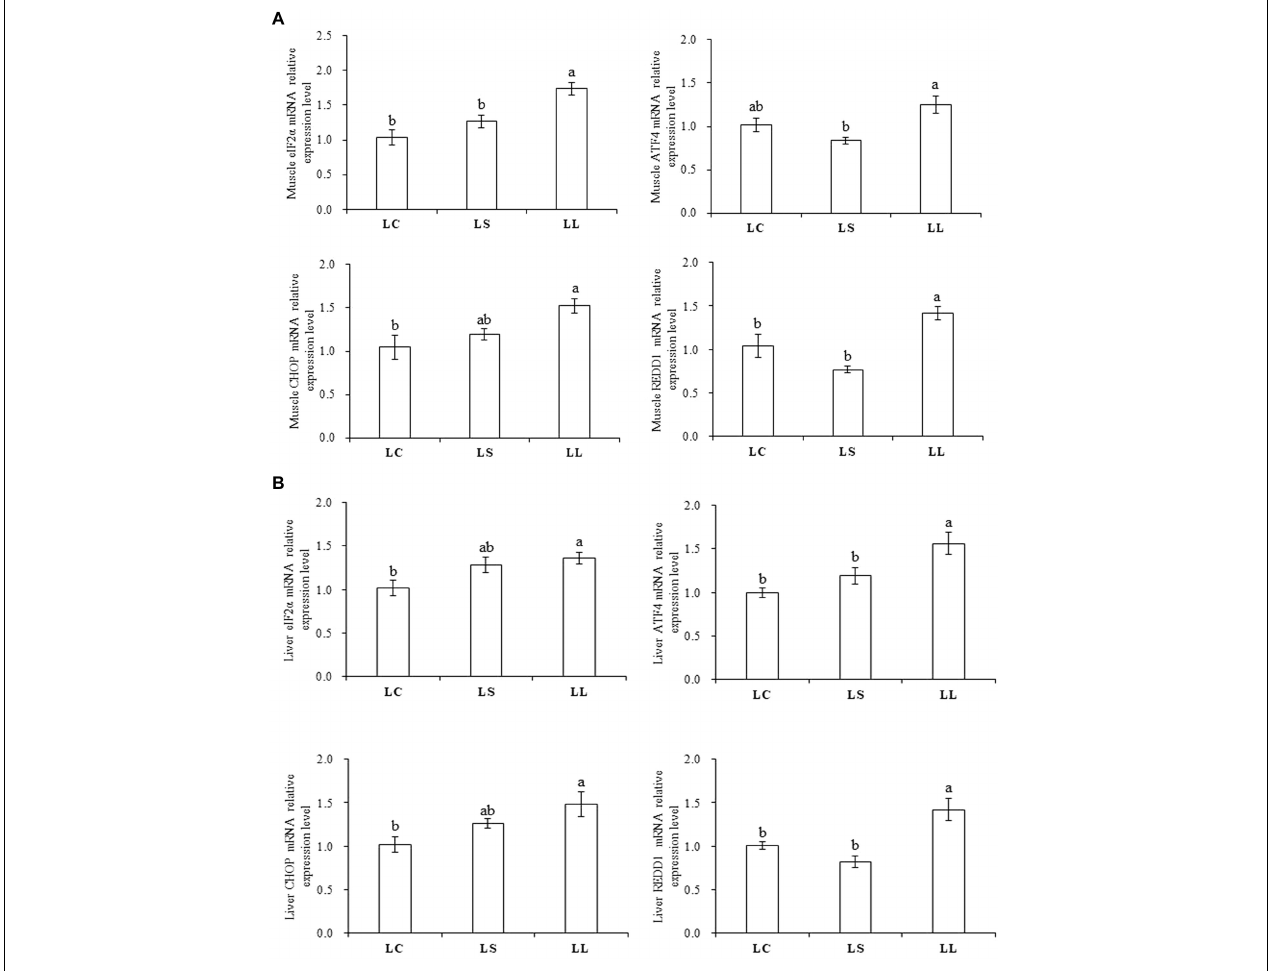
FIGURE 4 | Effects of the LC diet, LL diet supplemented with dietary lysine (LS diet) and the LL diet on muscle (A) and liver (B) mRNA expression levels of key regulators involved in AAR signaling pathway. Different superscript letters “a, b” indicated statistical significant differences ( P < 0 . 05; mean ± SEM, n =